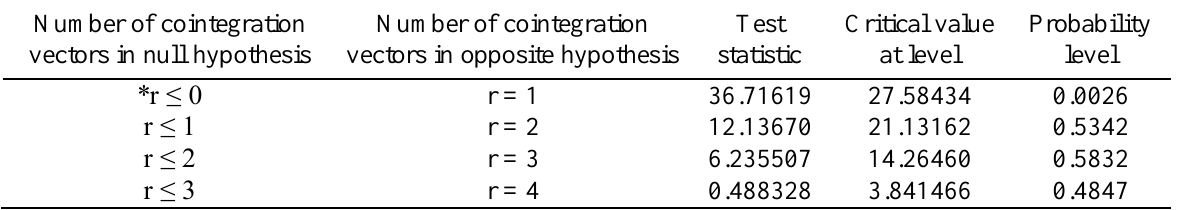
Table 4. Results of the Johanssen cointegration test according to Max-Eigen statistic Number of cointegration vectors in null